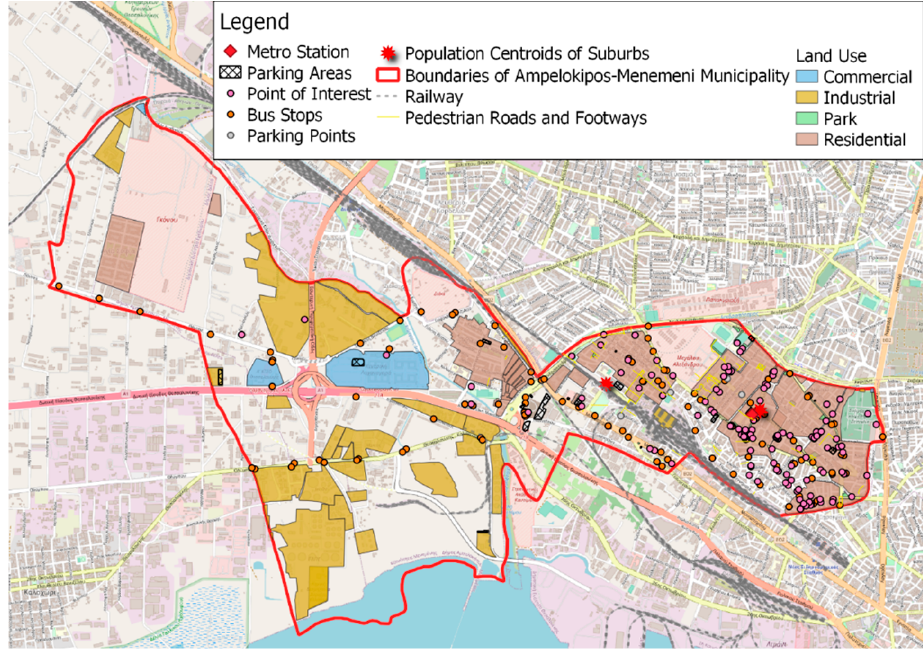
Figure 1. This is a figure. Schemes follow the same formatting (Background map: © OpenStreetMap contributors [88]). contributors